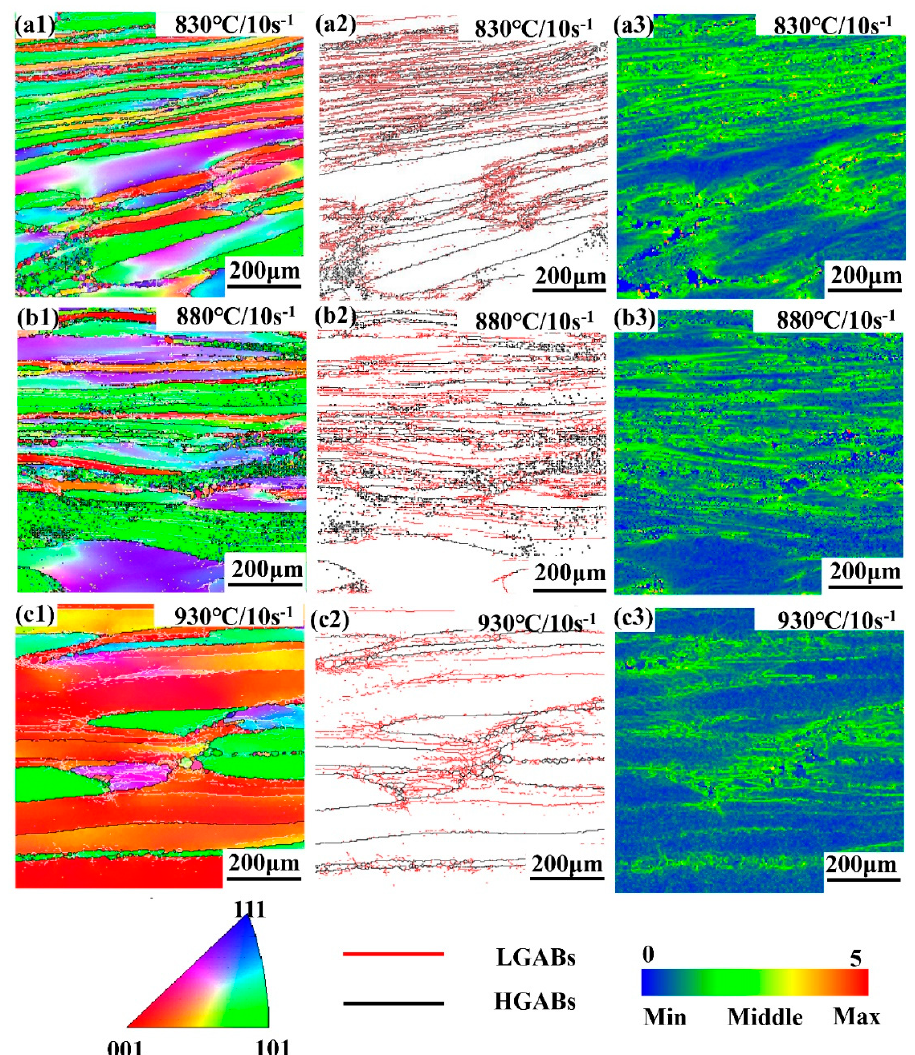
Figure 15. The EBSD analysis results of Ti-35421 alloy deformed at 10 s − 1 under different temperatures of β phase region: ( a ) 830 °C, 10 s − 1 , ( b ) 880 °C, 10 s − 1 , ( c ) 930 °C, 10 s − 1 where the (1) is inverse pole figure, (2) is distribution of grain boundaries at high and low angle, and (3) is Kernel average misorientation under each condition.